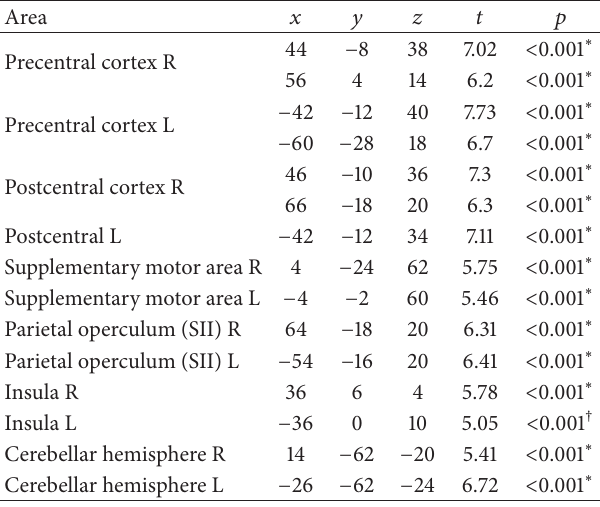
Table 3: Peak coordinates, 𝑡 -statistics, and uncorrected 𝑝 values for significant brain activations during the perception of severe versus mild dyspnea.